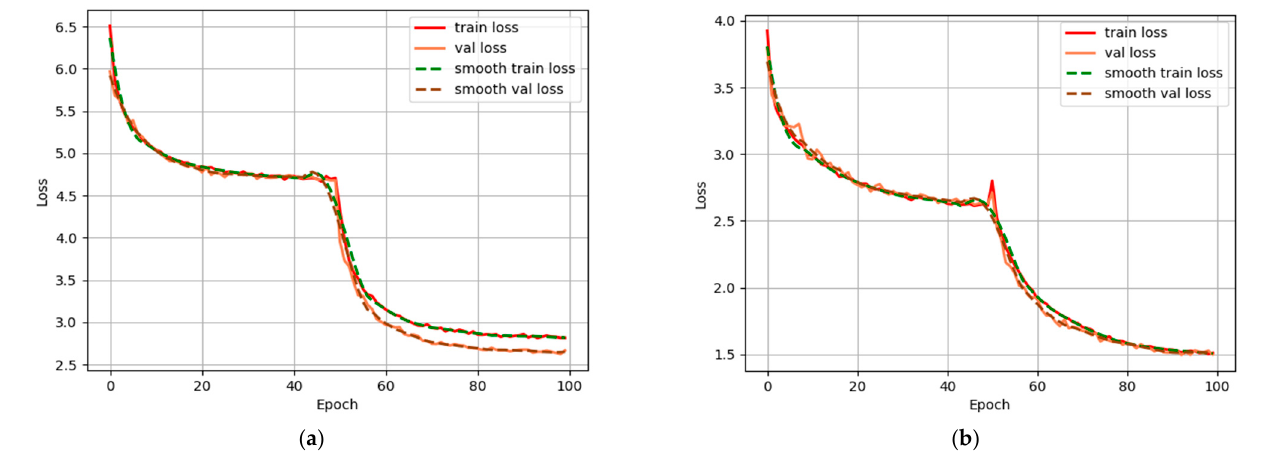
Figure 7. Comparison of YOLOX_s network and CBAM-YOLOX network Loss curves. ( a ) YOLOX_s network Loss curve; ( b ) CBAM-YOLOX network Loss curve.